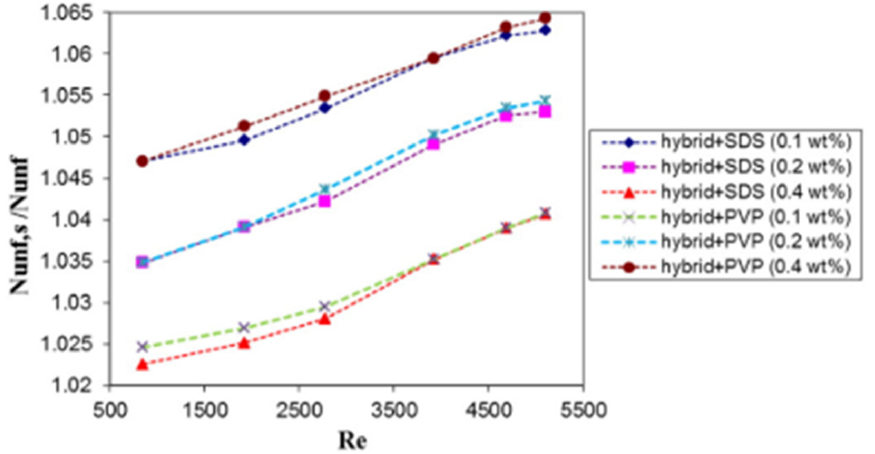
Figure 22. Nusselt number enhancement ratio against Reynolds number for hybrid NF at different concentrations of surfactant (SDS or PVP). Adapted from [65].